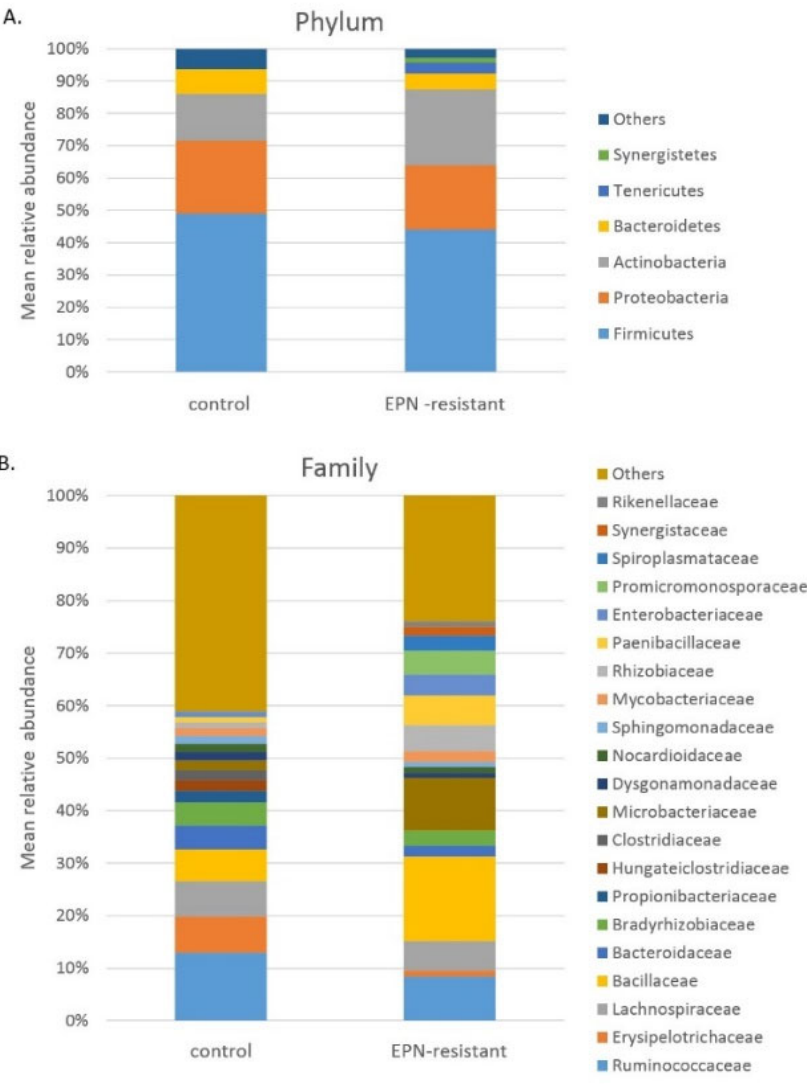
Figure 1. Composition of midgut bacteria of A. solstitiale larvae: ( A ) phylum level, ( B ) family level. 3.5. Comparison of the Midgut Microbiota between the T0 and the EPN-Resistant